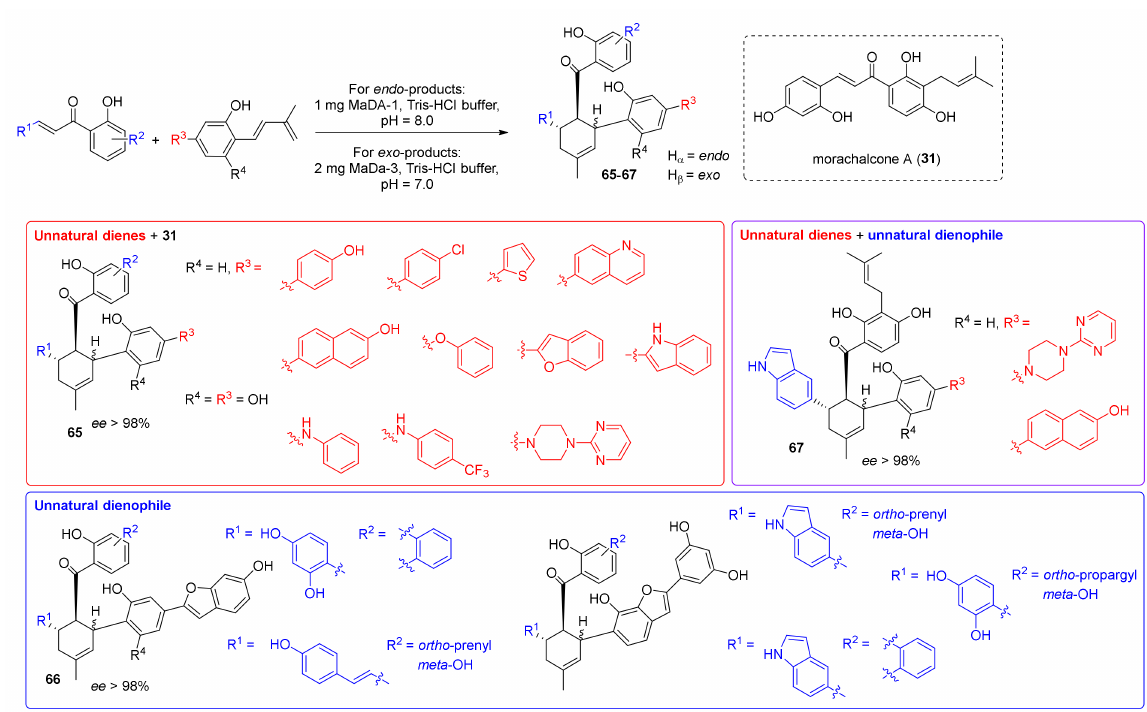
Figure 19. Chemoenzymatic synthesis of unnatural DAAs using MaDA-1 and